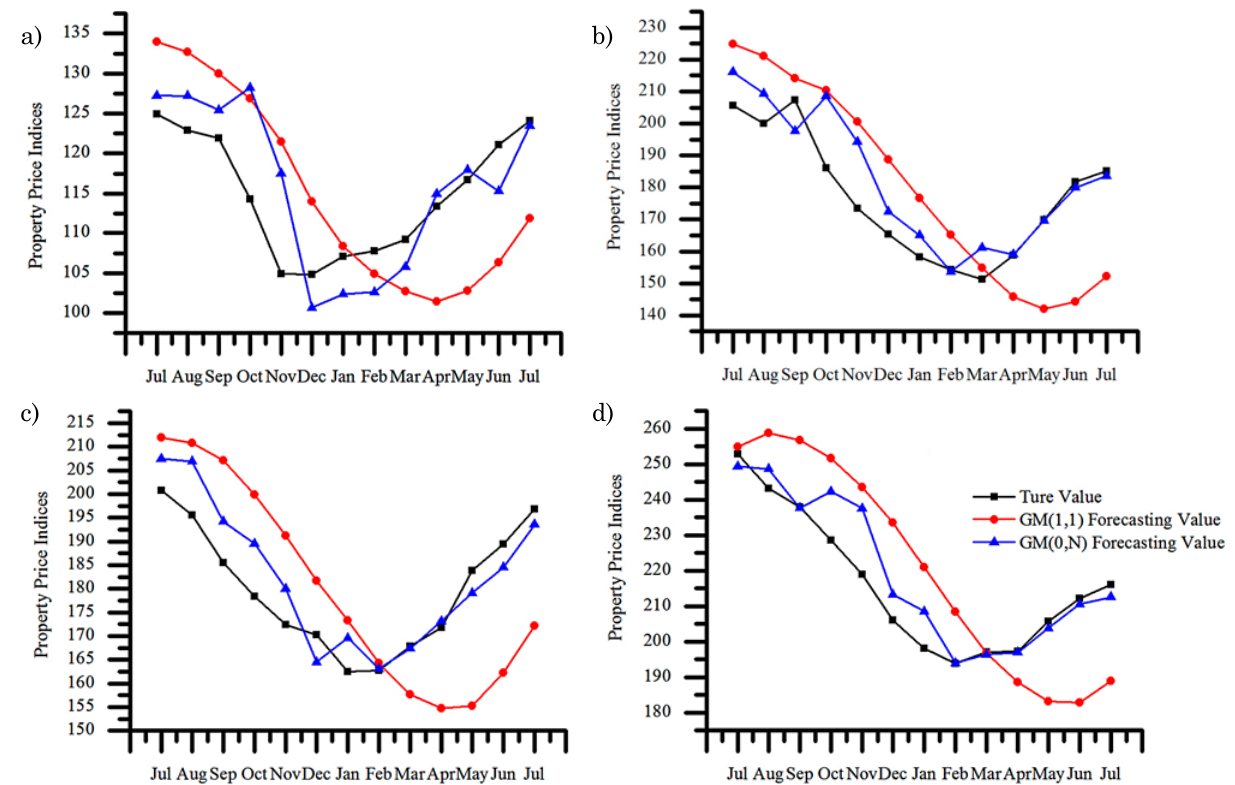
Fig. 7. Fitting lines of four sectors for fluctuating data (Jul 2008–Jul 2009) (a) domestic (b) office (c) retail (d)